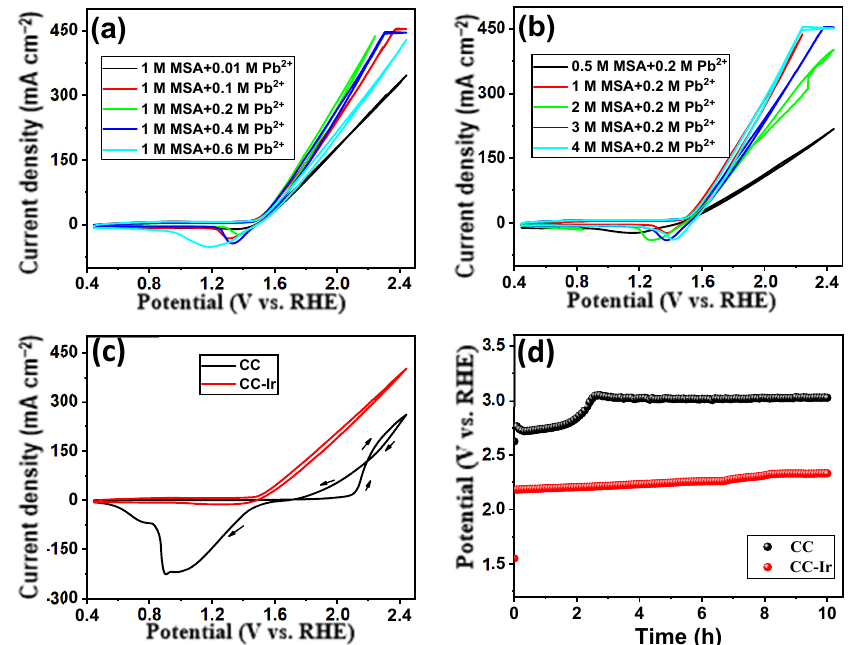
Figure 5. CV curves of CC-Ir in electrolyte with ( a ) Pb 2+ concentration from 0.01 to 0.6 M, and ( b ) MSA concentration from 0.5 to 4 M. ( c ) CV curves and ( d ) constant current electrolysis curves of CC and CC-Ir in lead methanesulfonate electrolyte with 0.2 M Pb 2+ and 1 M MSA.